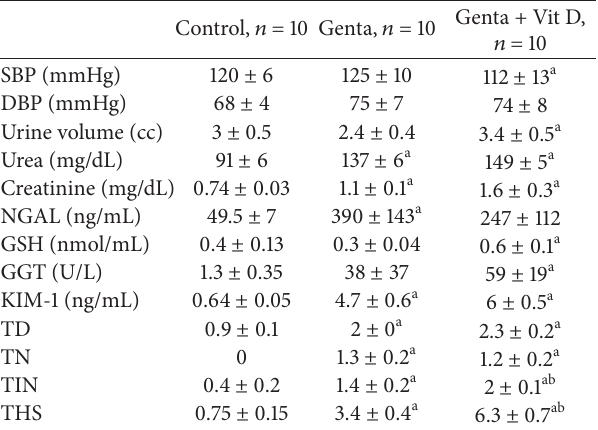
Table 1: Clinical and laboratory